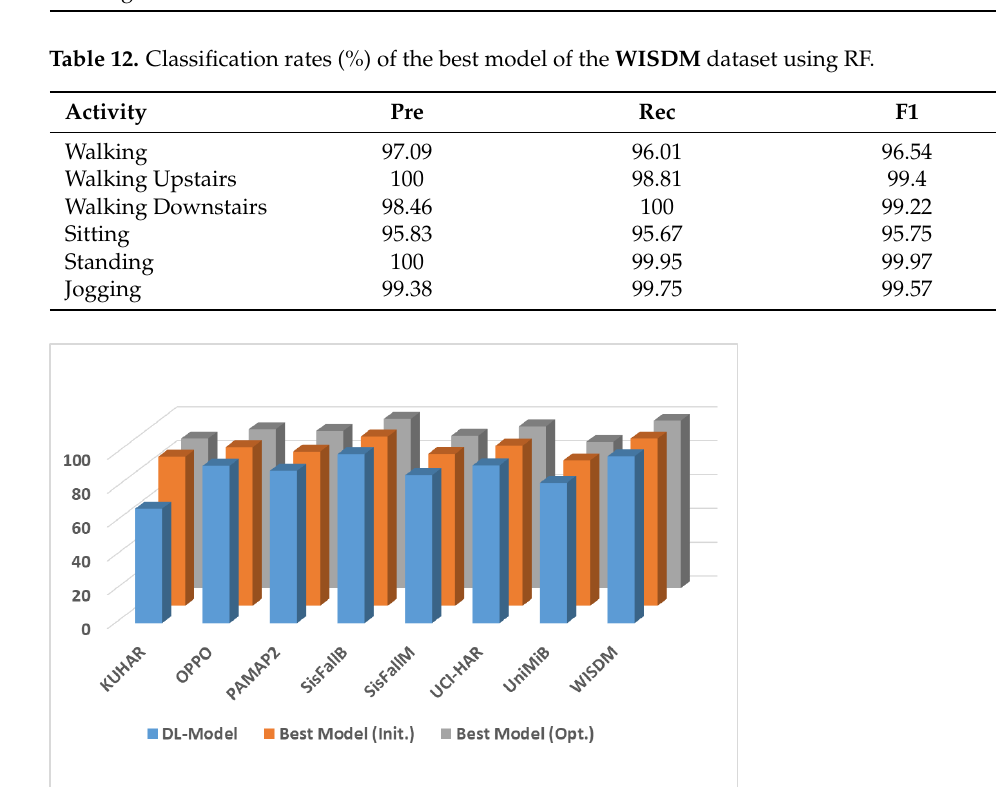
Figure 5. Comparison of the average accuracy of the applied DL model, DL model using RF and SVM (best model (Init.)), and the optimized DL model (best model